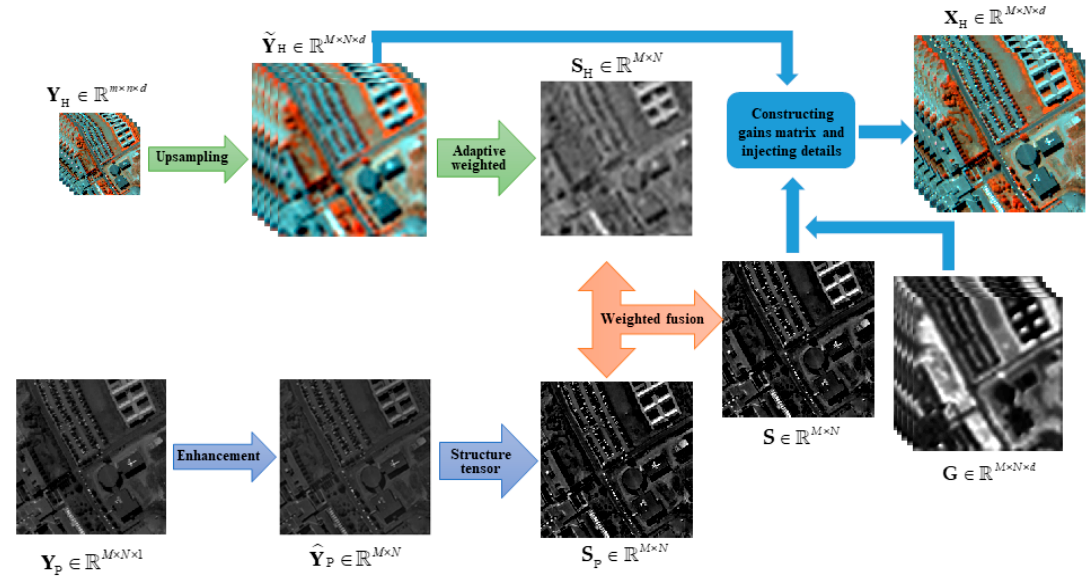
Figure 1. Diagram of the proposed hyperspectral image fusion algorithm. ( m and M ( m < M ) represent the image height of the original HS and PAN images, respectively. n and N ( n < N ) represent the image width of the two images, and d represents the number of the HS image bands.).